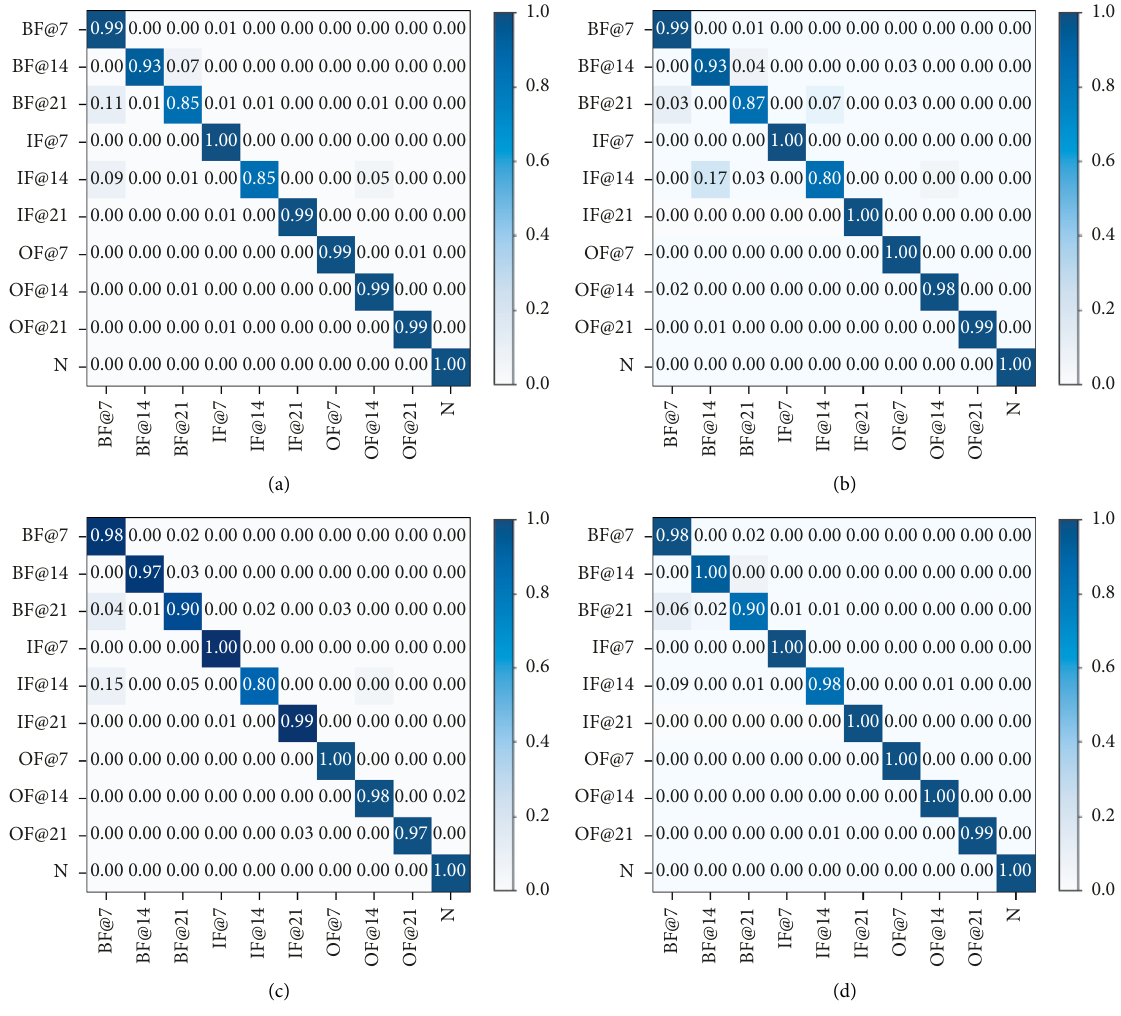
Figure 7: Confusion matrix of the prediction for task A ⟶ B: (a) CNN; (b) DDC; (c) DAN; (d) the proposed.